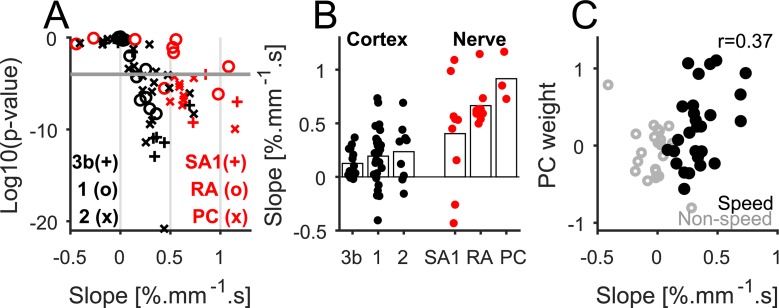
Speed coding in single cortical units.(A) p-Value versus normalized regression slopes for each neuron. Black denotes cortical neurons, and red denotes nerve fibers. Marker type denotes cortical field or fiber type (see legend). The gray line denotes the threshold for significance (10−4). (B) Regression slope for each neuron, classified by area and fiber type (bars show the mean across neurons). (C) PC weight as a function of regression slope for each neuron. Neurons with higher PC input tend to be more sensitive to speed. Data underlying this figure can be found in S1 Data. PC, Pacinian corpuscle–associated; RA, rapidly adapting; SA1, slowly adapting type 1.